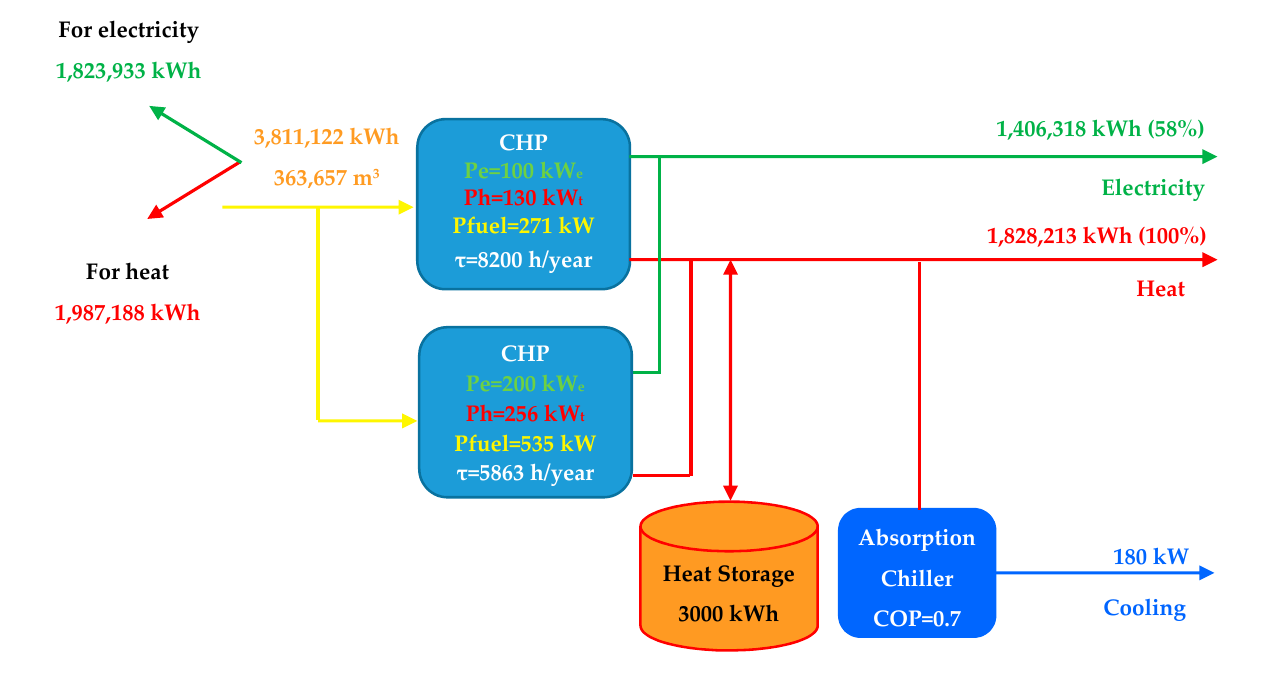
Figure 26. Trigeneration with two units (2 × 100 kW e , 2 × 130 kW t ) and heat storage (3000 kWh). Table 7. Trigeneration (2 × 100 kW e , 2 × 130 kW t ) and heat storage: summary results. By introducing heat storage and using the heat available during the summer in an absorption refrigeration system, the operating time at the rated thermal load will increase to 8200 h/year for the first CHP unit, and 5863 h/year for the second CHP unit.